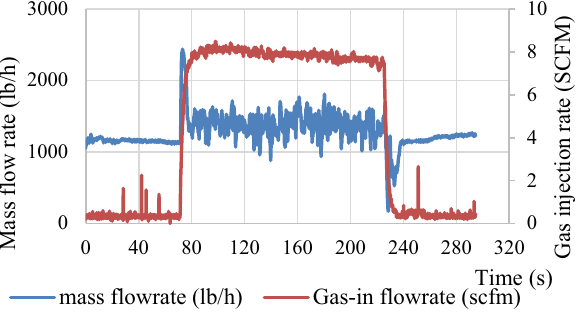
Fig. 13 Effects of gas kick on mass flow rate of the return fluid